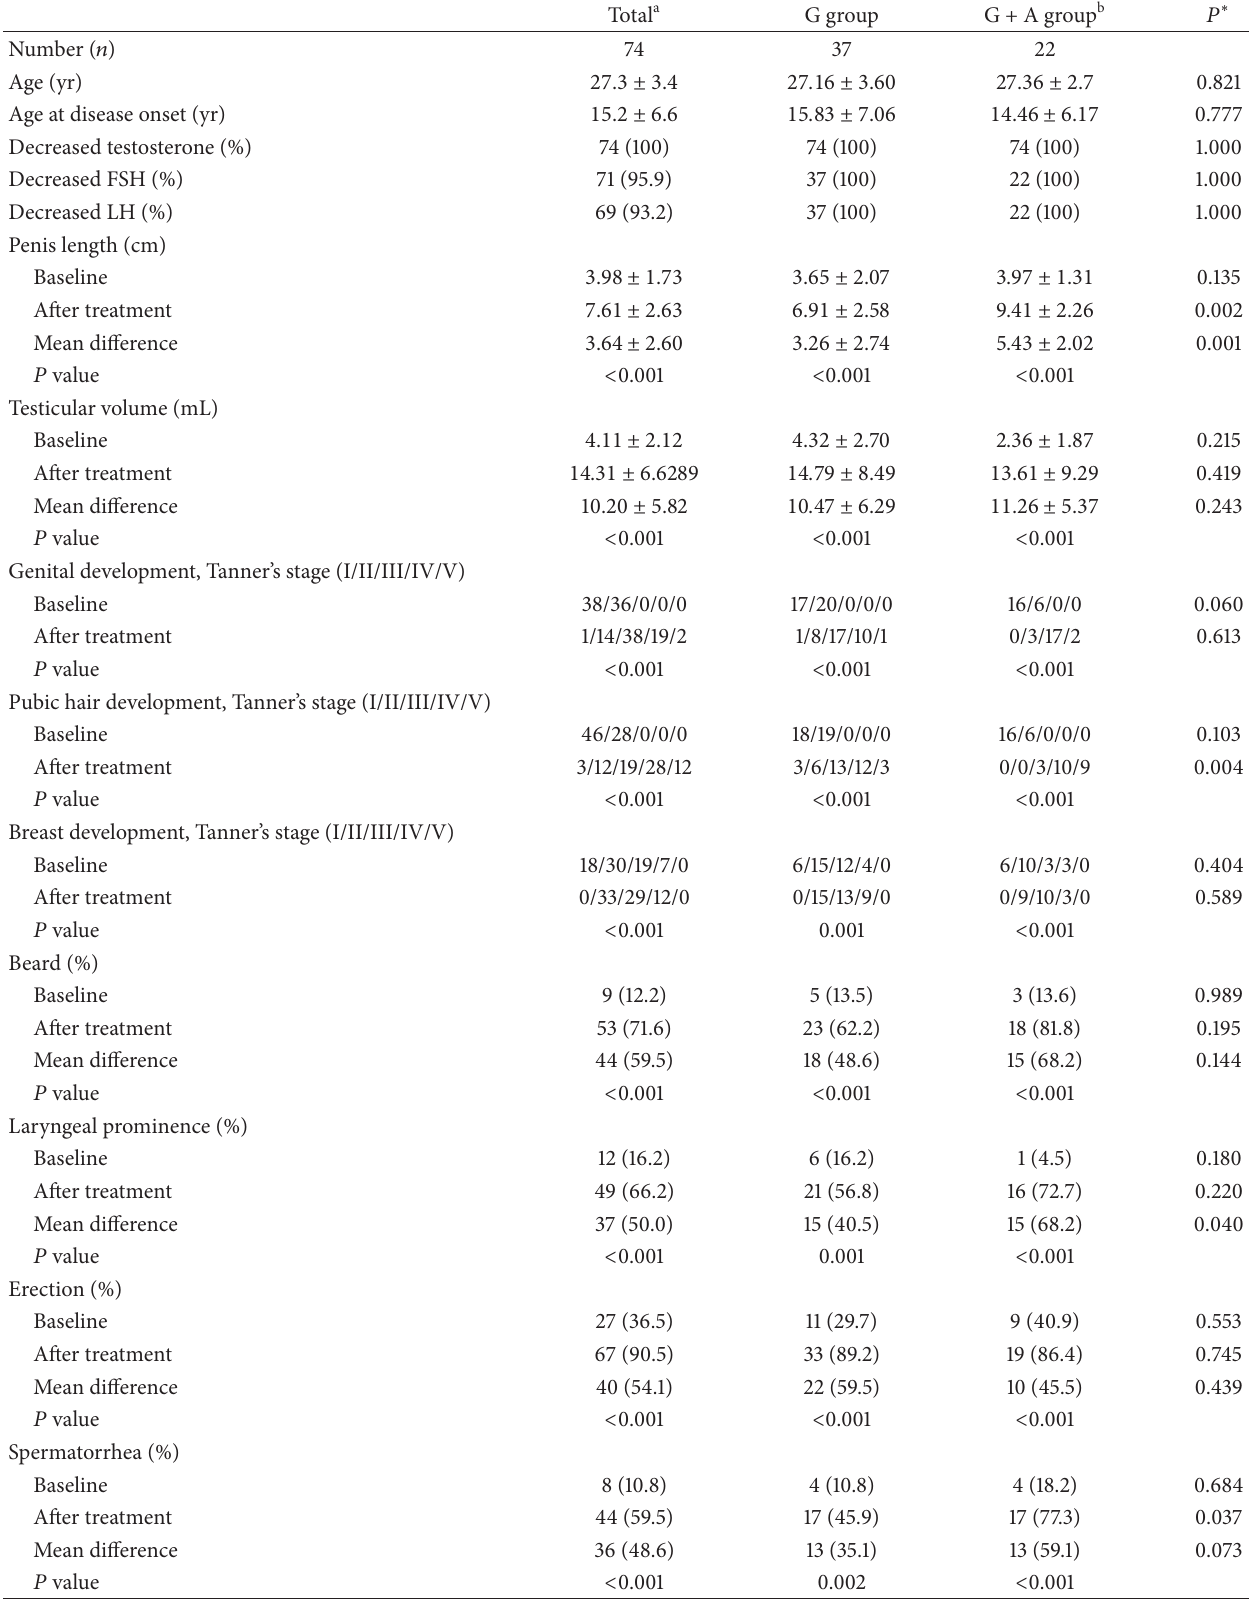
Table 3: Characteristics of the 74 IHH patients: G group patients and G + A group